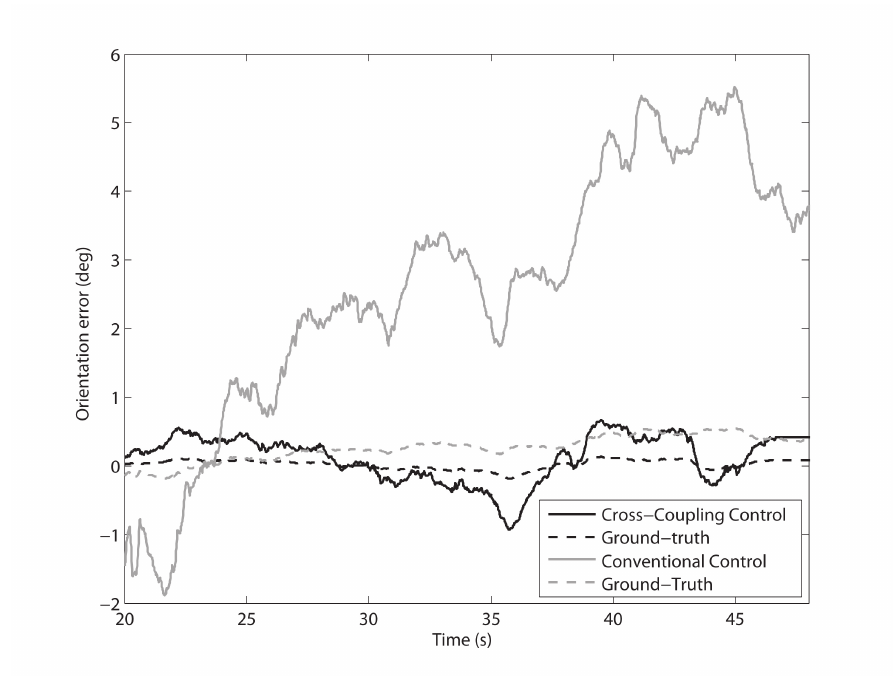
Figure 9. Comparison of cross-coupled control with conventional control: Change in the orientation error during a single 5-meter straight path test on asphalt road (V = 10 cm/s). Black solid line: Encoder-derived orientation error using the CCC. Black dashed line: Gyro-derived ground truth. Grey solid line: encoder-derived orientation error using the CC. Grey dashed line: Gyro-derived ground